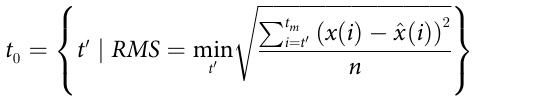
infectious curves is performed in two steps, using the parameters known to be active (cf. Table 1). First, we estimate the “model consistent” date of first infection, so that the simulated curve matches the reported data of active infections. This initial step corresponds to setting the time initial conditions of the SEIR model [17]. The fitting is performed with default parameter values, on a subset of data corresponding to the first outbreak, from first case until when mea- sures are implemented (cf. Table 1). We use a grid search method for least squares, sufficient to fit a single parameter: